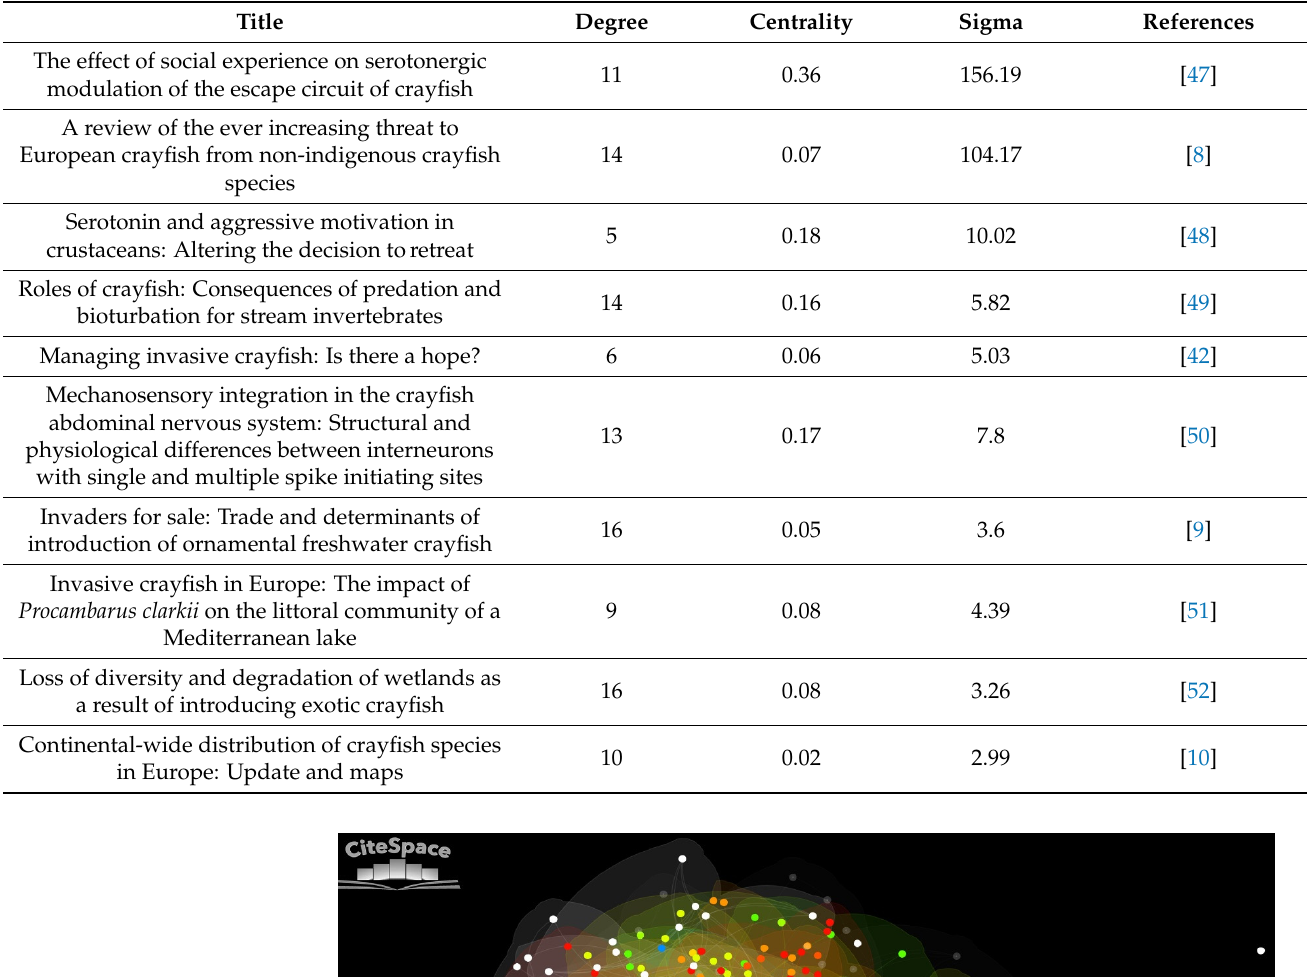
Table 7. Top 10 publications identified by the co-citation analysis, ranked according to Sigma scores.